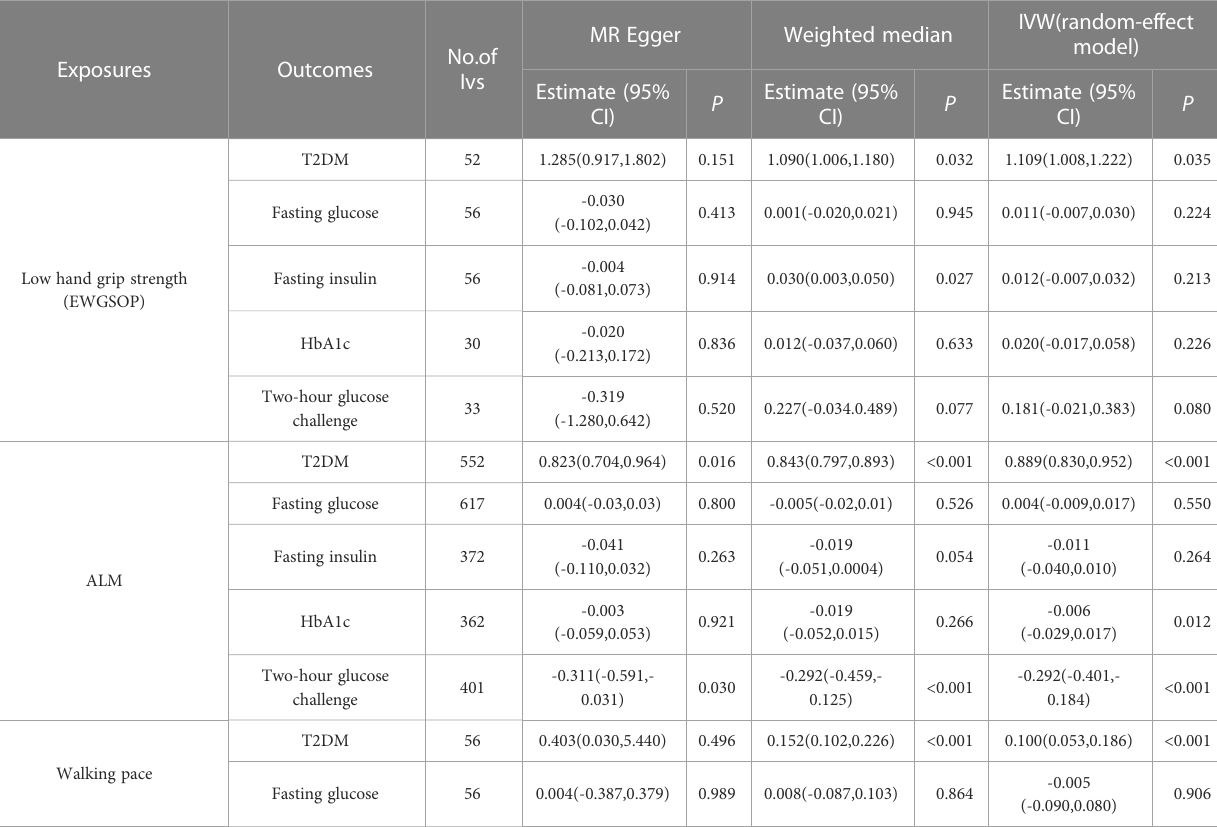
TABLE 3 Association sarcopenia-related traits with T2DM and glycaemic traits using Mendelian randomization. Exposures